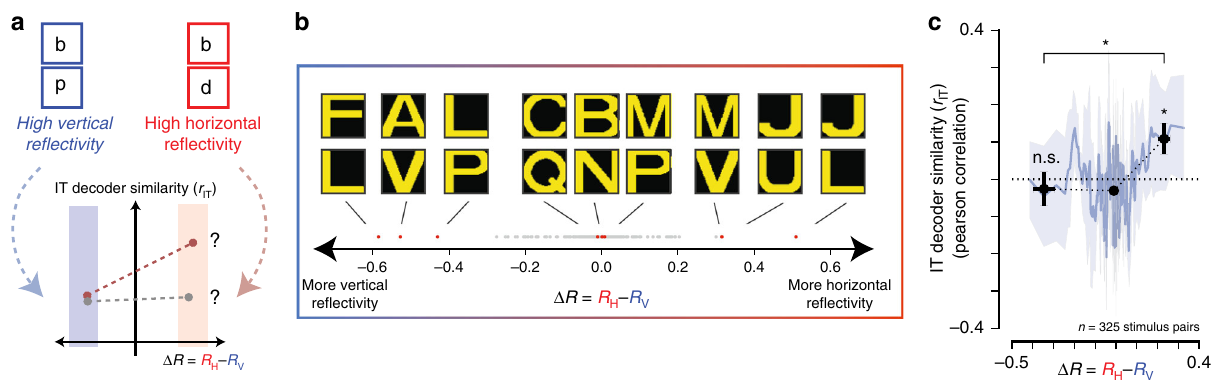
Fig. 5 Test of mirror symmetry in IT. a If the left-right inversion errors of early readers are due in part to the high-level visual representation of letters, this predicts that the IT population decodes should be more similar (i.e., more likely to be confused) for pairs of letters that have high horizontal re fl ectivity (e.g., “ b ” and “ d ” ), compared to pairs of letter than have high vertical re fl ectivity (e.g. “ b ” and “ p ” ). In other words, we predict r IT to be greater for positive Δ R than for negative Δ R (bottom, red curve). b We quanti fi ed the amount of horizontal and vertical mirror symmetry between all 325 pairs of letters in our stimulus set, and sorted them along the dimensions of Δ R (see text). The gray dots show the corresponding distributions for each, with nine example stimulus pairs (red dots) selected to span the entire range. c The dependence of IT-decoder representational similarity r IT to the empirically measured Δ R, overall 325 letter pairs. The smooth blue line shows the rolling average using a boxcar window of fi ve stimulus pairs. We binned Δ R into three bins spanning three equal Δ R ranges; the black markers show the average r IT for each bin (mean ± SE over stimulus pairs). We observe a positive average r IT for the rightmost bin, but not for the left-most; the difference between these two measurements was modest but signi fi cant. Asterisk corresponds to p < 0.05 obtained by unpaired one-tailed two-sample t